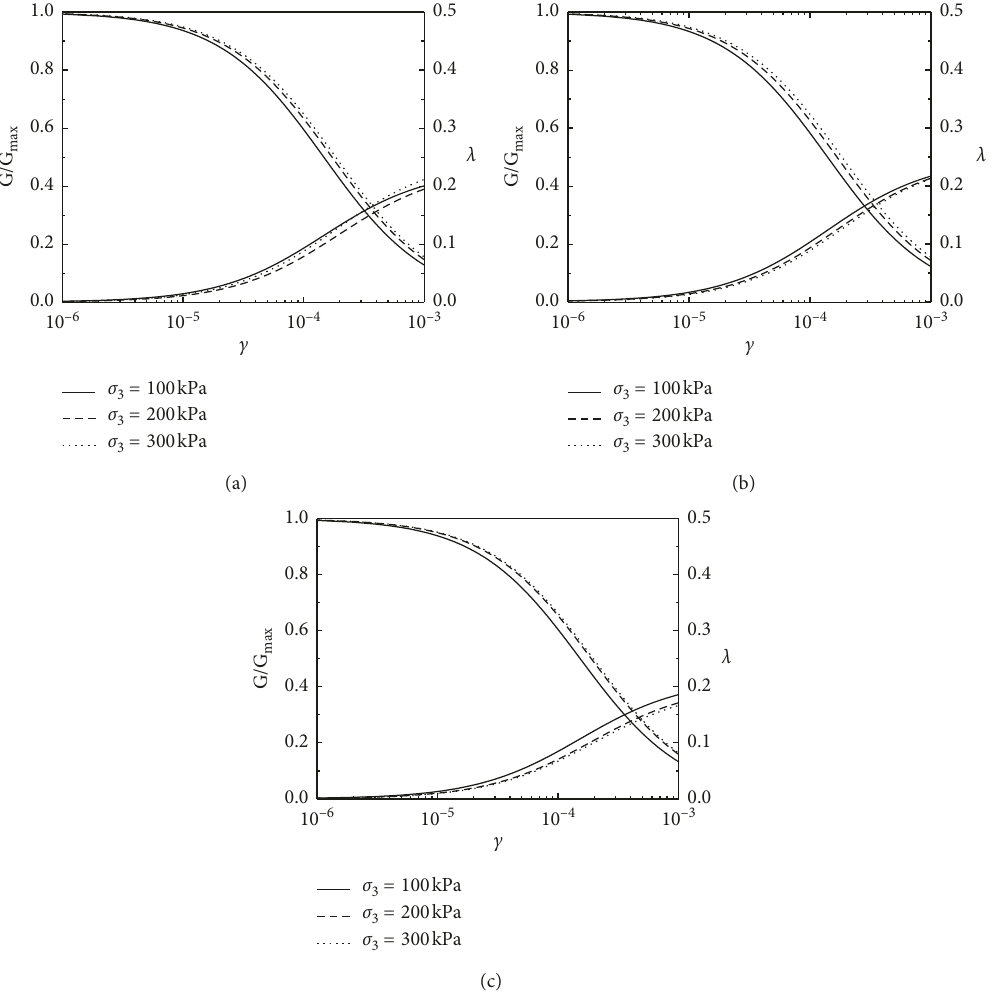
� 0.3; (b) D � 0.5; (c) D � 0.7. r r r